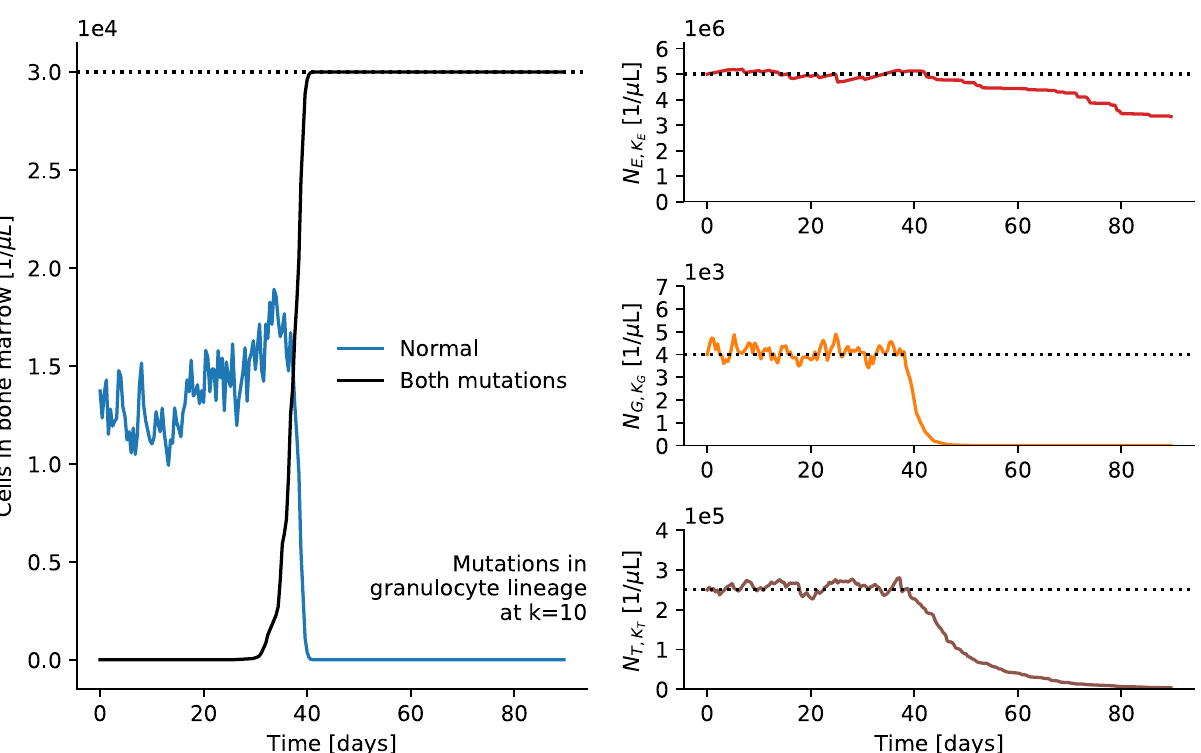
Fig 8. Late mutations. Mutations for unlimited replication and a differentiation block are introduced in the granulocyte lineage at stage k = 10 at time zero. The break-down of hematopoiesis happens much earlier than in Fig 7, where the mutation occurred earlier in the system.